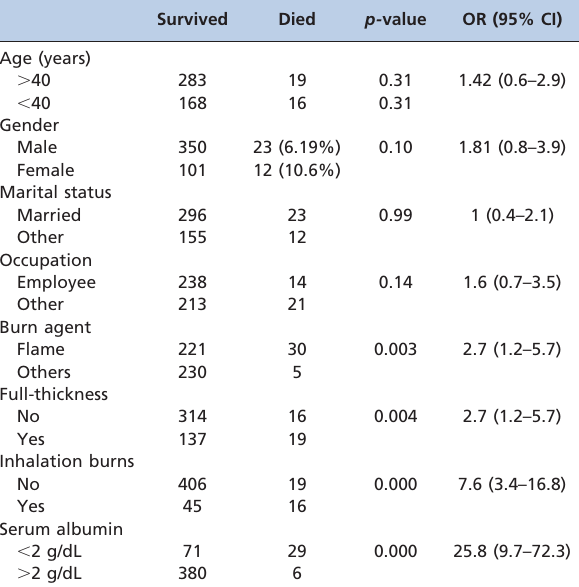
Table 3 - Univariate analysis.